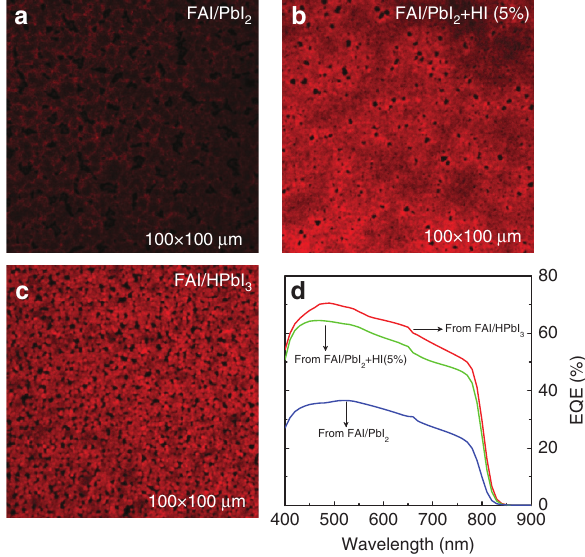
Figure 1 Confocal laser scanning microscopy of FAPbI 3 fi lms prepared from different precursors. ( a ) FAI/PbI 2 , ( b ) FAI/PbI 2 with 5% HI and ( c ) FAI/HPbI 3 . ( d ) EQE spectra of FAPbI 3 solar cells obtained from the three different precursors. EQE, external quantum ef fi